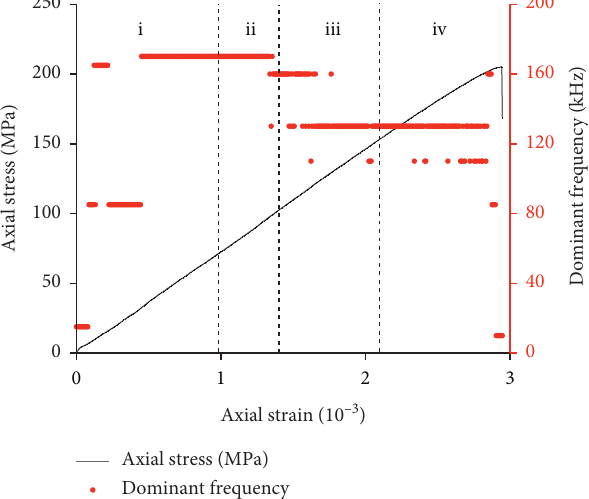
Figure 11: Dominant frequency variation of CH1-CH3 region in the uniaxial loading process of